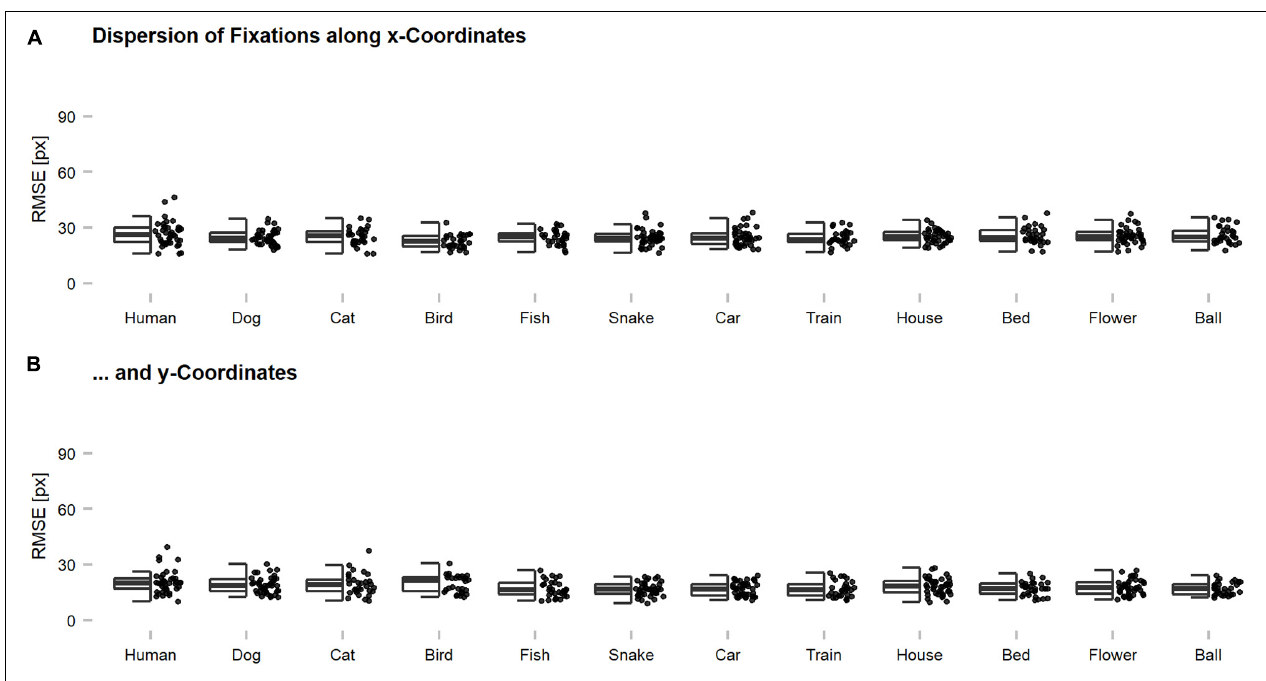
FIGURE 3 | Dispersion of eye tracking fixations along x- and y-coordinates across categories. Root Mean Squared Errors (RMSEs) were computed for individual images and indicate the magnitude of deviation among the fixations of individual participants on a single image. Generally, the fixations seemed to be rather precise on an image-by-image level with an average dispersion of below 30 pixels across all participants. This suggests that meaningful features were targeted and that the centroids, which were used for further analyses, can be regarded as characteristic for the human observer sample. The dispersion along (A) x-coordinates was slightly higher as compared to (B) y-coordinates, which is thought to reflect the reported central fixation and saccadic motor biases. The dispersion of an image can also be increased by the presence of multiple meaningful features, without any loss of precision. However, this problem should occur rarely, as most of the images showed only one dominant object.